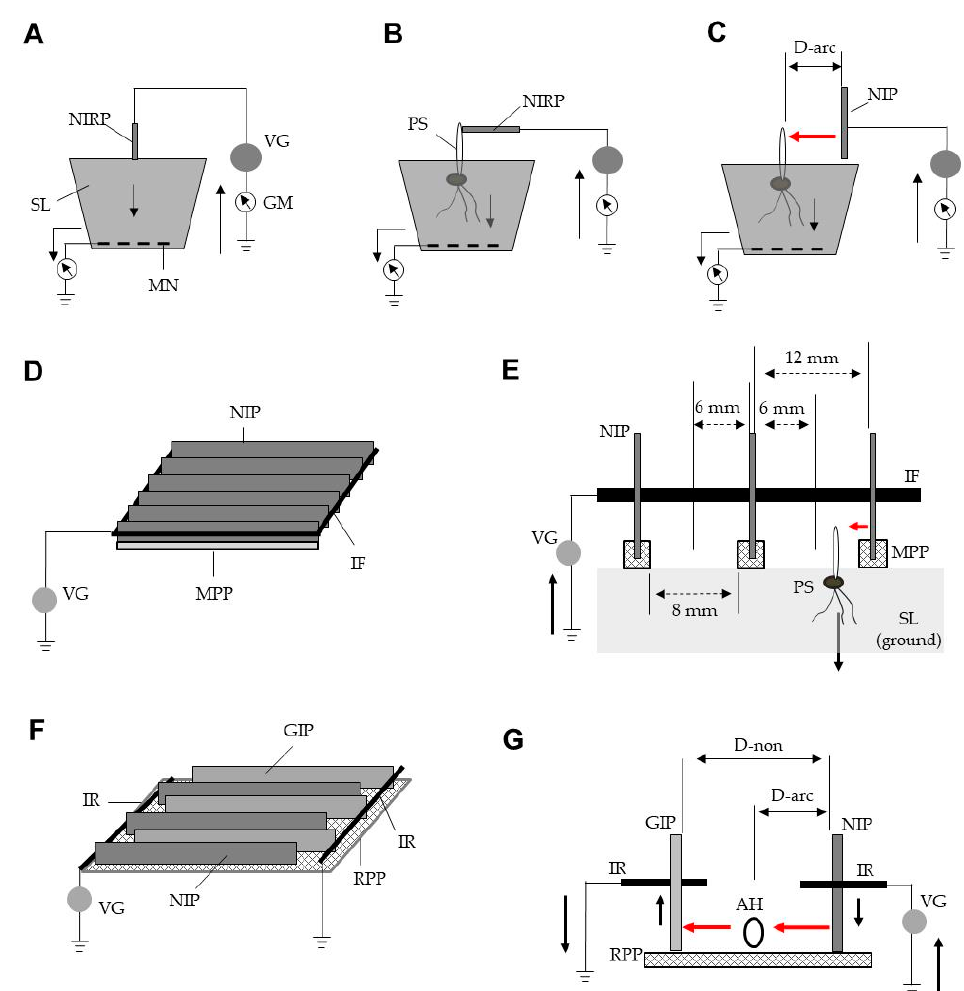
Figure 1. ( A – C ) Methods for examination of soil electric conductivity, examination of plant shoots grown in soil, and exposure of plant shoots to arc discharge, respectively. ( D ) Configuration of an electrostatic weed-eradicator (EWE). ( E ) Cross-sectional view of the EWE. ( F ) Configuration of an electrostatic insect-eradicator (EIE). ( G ) Cross-sectional view of the EIE. Solid arrows represent the movement of electricity, while red arrows show aerial movement of electricity through arc discharge. Abbreviations: NIRP, negatively charged iron rod probe; SL, soil; MN, metal net; VG, voltage generator; GM, galvanometer; PS, plant shoot; NIP, negatively charged iron plate (conductor); IF, iron frame; MPP, mortised polypropylene plate (insulator); GIP, grounded iron plate (conductor); IR, iron rod; RPP, reticulate polypropylene plate (insulator); AH, adult housefly; D-non, distance causing no arc discharge; D-arc, distance causing arc discharge.